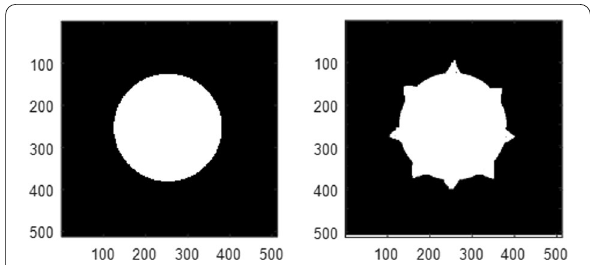
Fig. 7 Two apertures corresponding to the confocal microscope lenses. In the L.H.S., circular aperture is shown while in the R.H.S., the aperture is provided with 8 spikes (1st model of Covid 19). The two apertures have the same sizes of radius 128 pixels and the whole = matrix has dimensions of 512